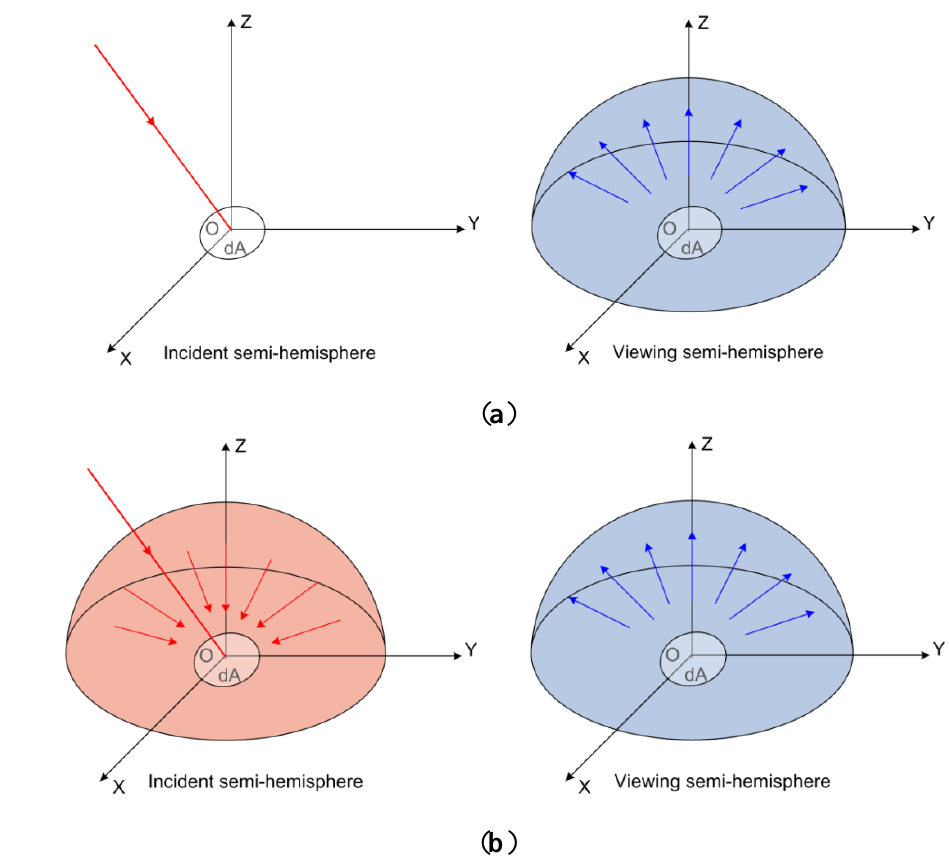
Figure 1. Definitions of the surface albedo. ( a ) Black-sky albedo; ( b ) White-sky albedo. The red lines indicate the incident directions and the blue lines indicate the viewing